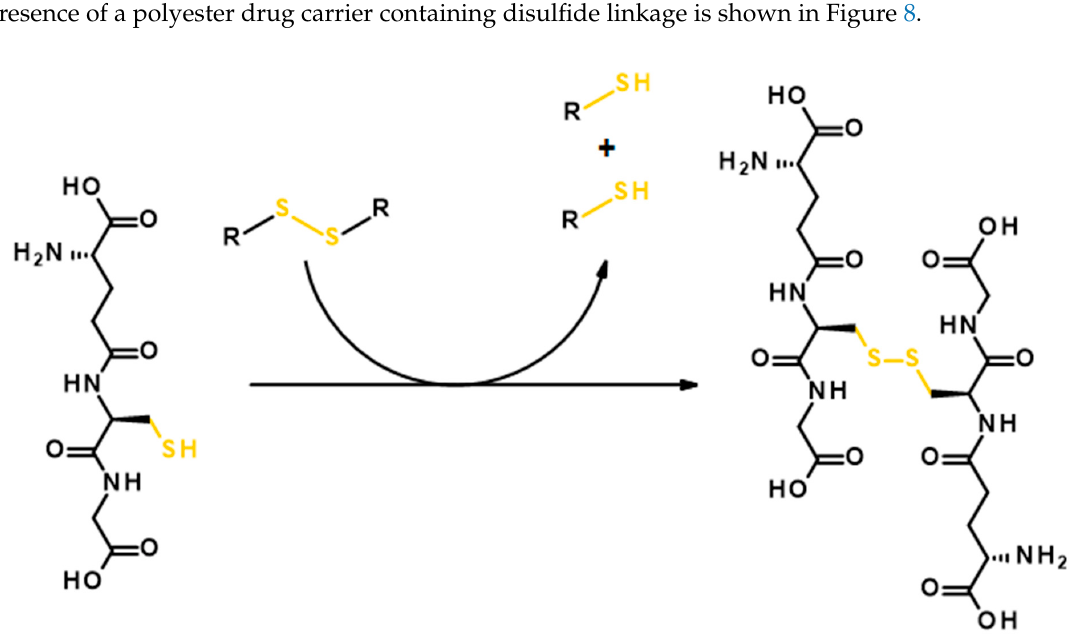
Figure 8. The scheme of reductive degradation of the disulfide bond with glutathione.